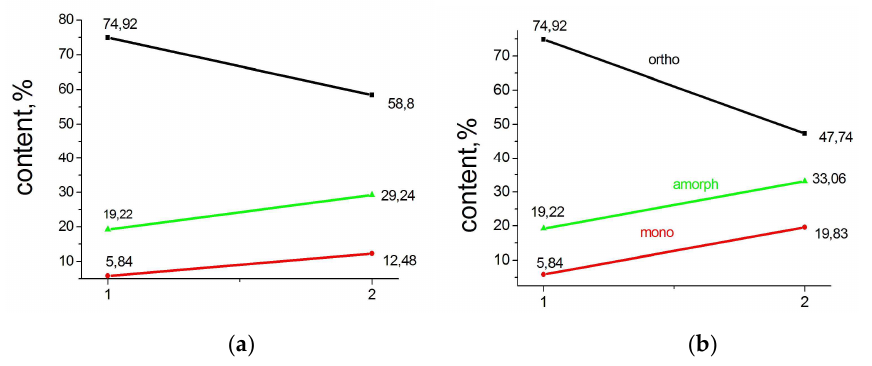
Figure 8. Change in the phase composition of SC particles 1 ( a , b ) subjected to pressure 1 GPa (2a) and 5 GPa (2b).